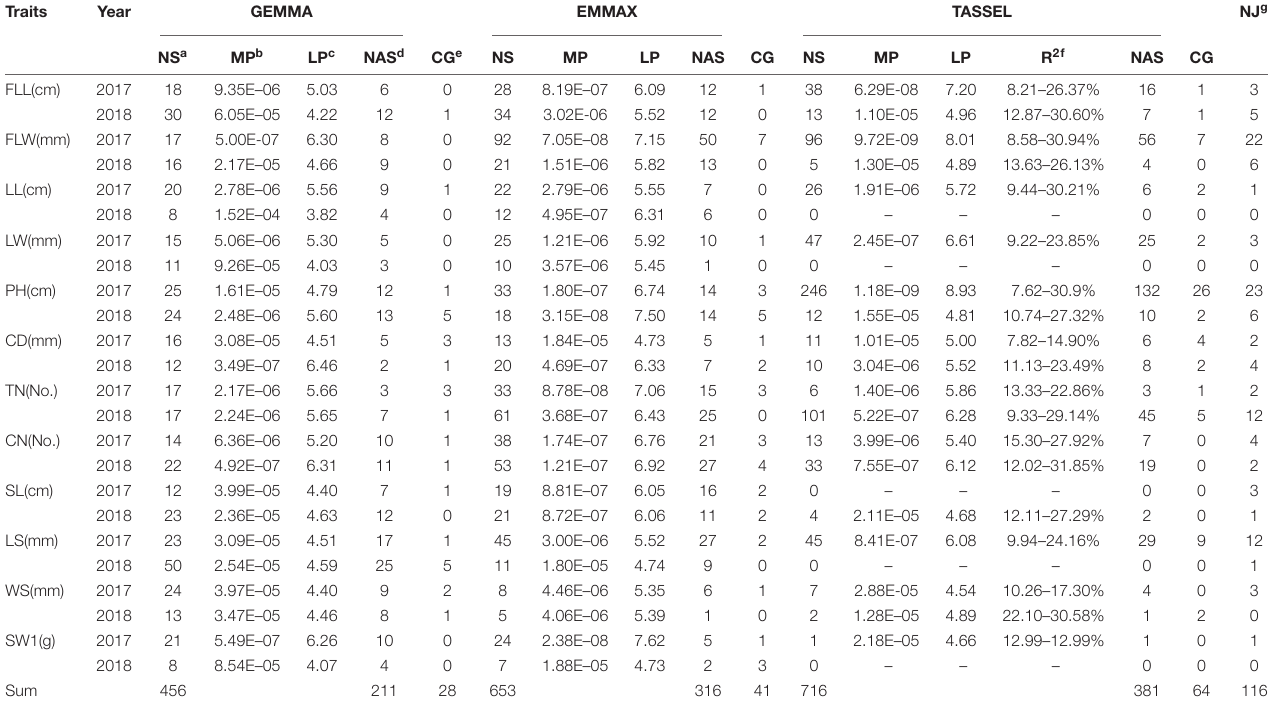
a Number of associated SNPs. b The min value of P. c The peak value of -lgP. d Number of annotated SNPs. e Number of candidate genes. f Percentage of variance explained. g Number of SNPs jointly annotated by more than two